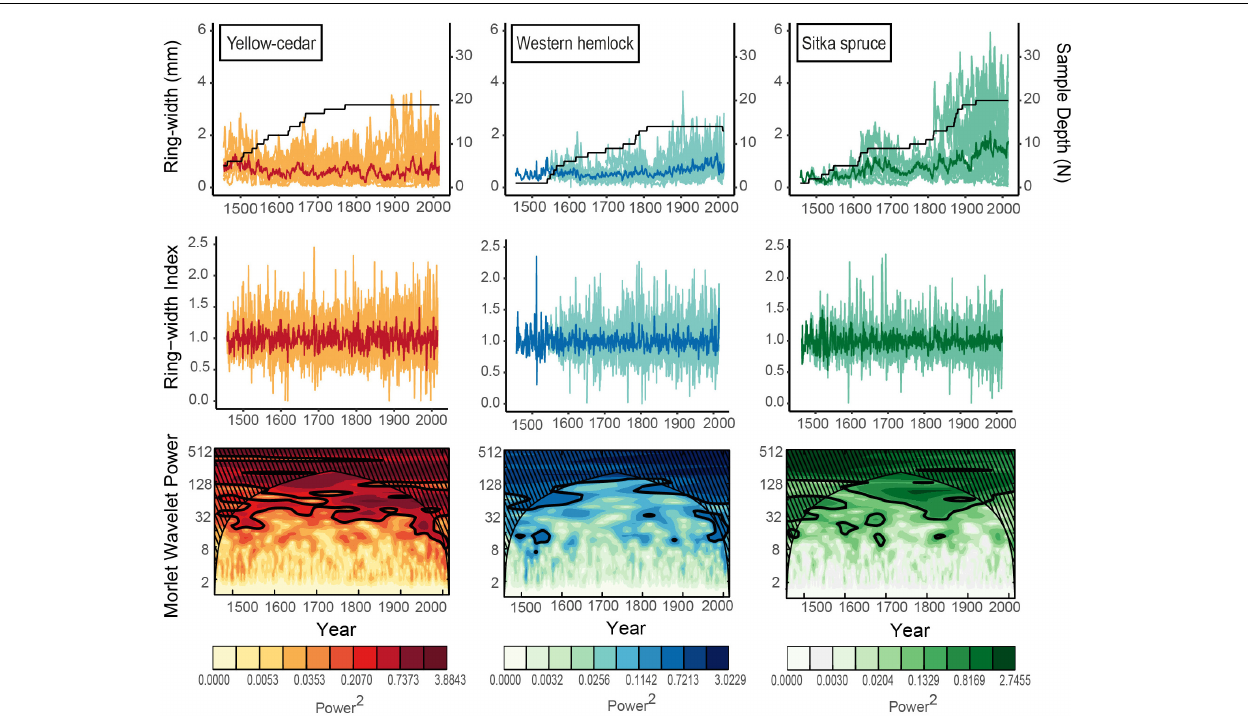
FIGURE 2 | Raw ring-width of individuals/mean (top), residual individual/mean ring-width index (middle) and wavelet analysis conducted on standard chronologies (bottom) for yellow-cedar ( n = 19), western hemlock ( n = 14) and Sitka spruce ( n = 20). Spanning 1457–2015, the common period of all three species chronologies.